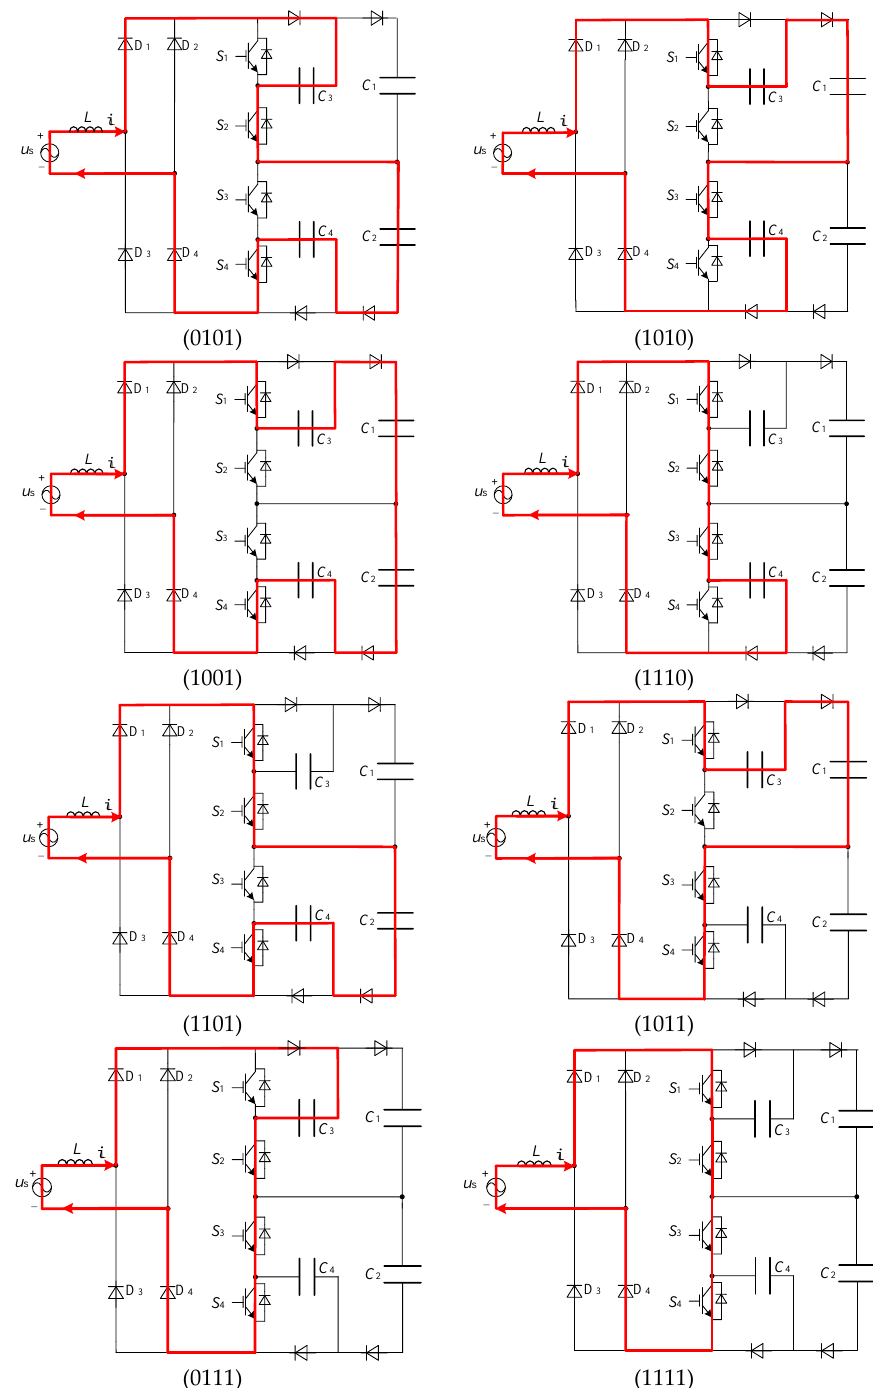
Figure 2. Modal analysis of single - phase five - level rectifier in the positive half cycle of voltage. 3. The Proposed SVPWM Algorithm for Single-Phase Five-Level